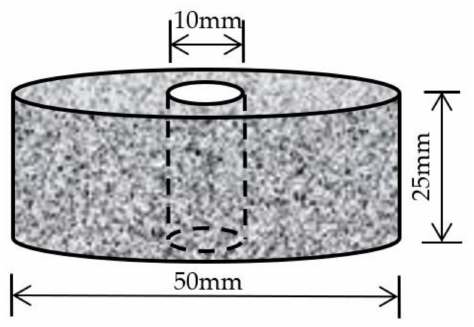
Figure 1. Drilling effect